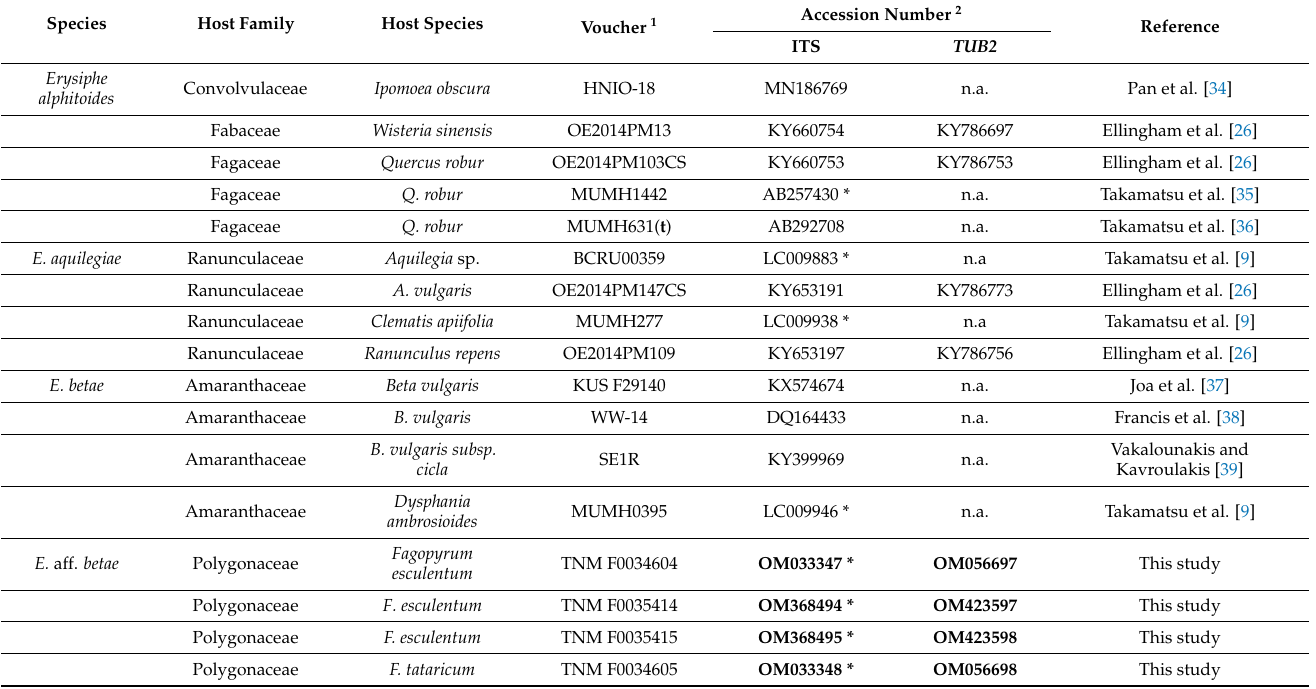
Table 1. List of powdery mildew isolates used in the phylogenetic